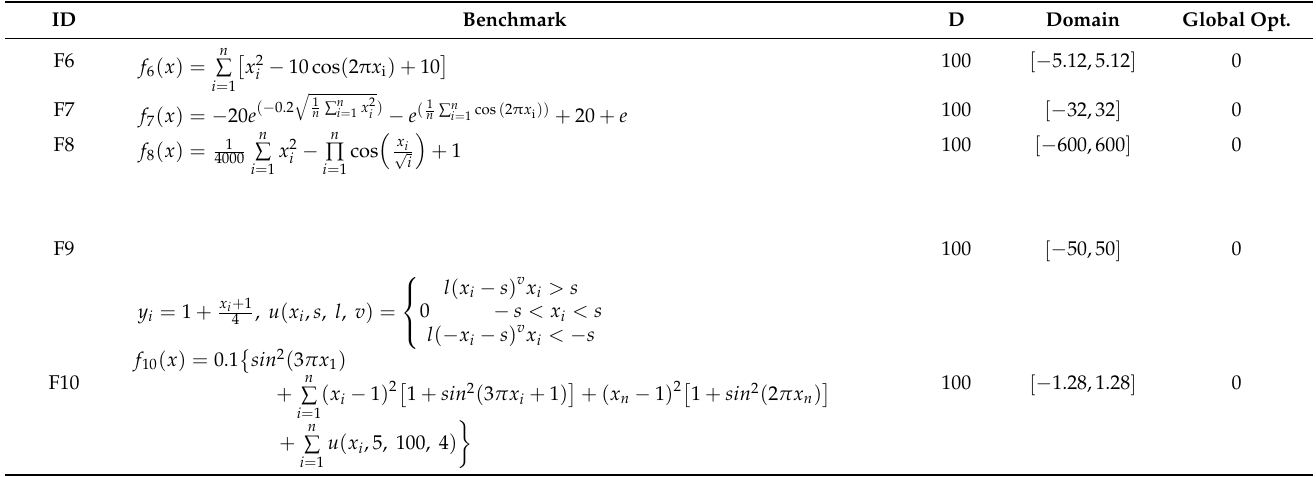
Table A2. Description of multi-modal benchmark